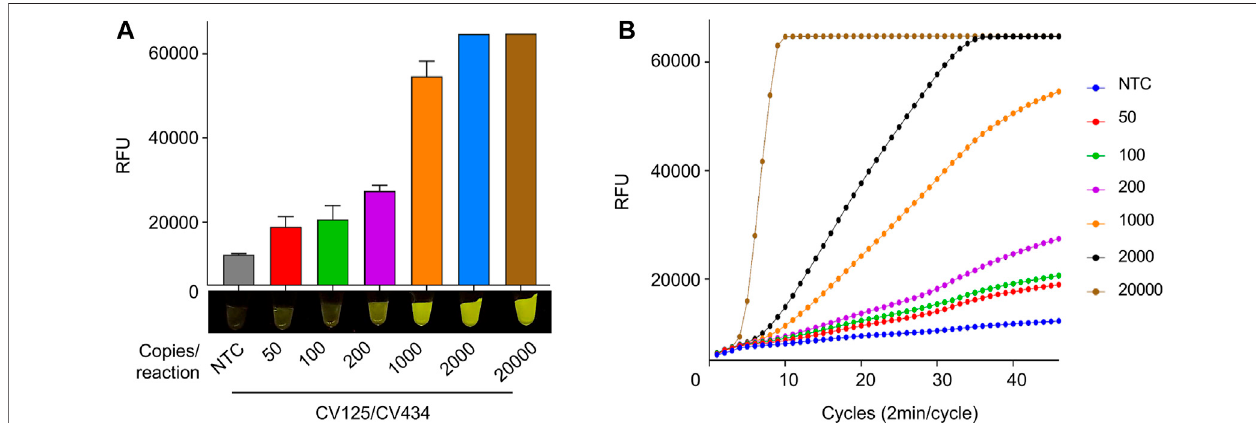
FIGURE 6 | LOD of synthetic SARS-CoV-2 RNA using iSCAN-V2. (A) Synthetic SARS-CoV-2 RNA (50, 100, 200, 1,000, 2,000, and 20,000 copies/reaction) was subjectedtotheiSCAN-V2detectionplatformusingprimersetCV125/CV434. (B) Real-timerepresentationofiSCAN-V2assaysperformedwithdifferentcopynumbers of synthetic SARS-CoV-2 RNA as shown in A. CFX96 (Bio-Rad) end-point fl uorescence (1 h) readouts were converted to graphical format using GraphPad Prism. For end-point fl uorescence data presentation, error bars (cid:1) means ± SD ( n (cid:1) 3). End-point fl uorescence was imaged in a P51 molecular fl uorescence viewer. For real- timerepresentation,theintensityofthe fl uorescentsignalwasmeasuredevery2 minforaperiodof1 h.Valuesshowninthegrapharemeansof3independentreadings. NTC, no template control.